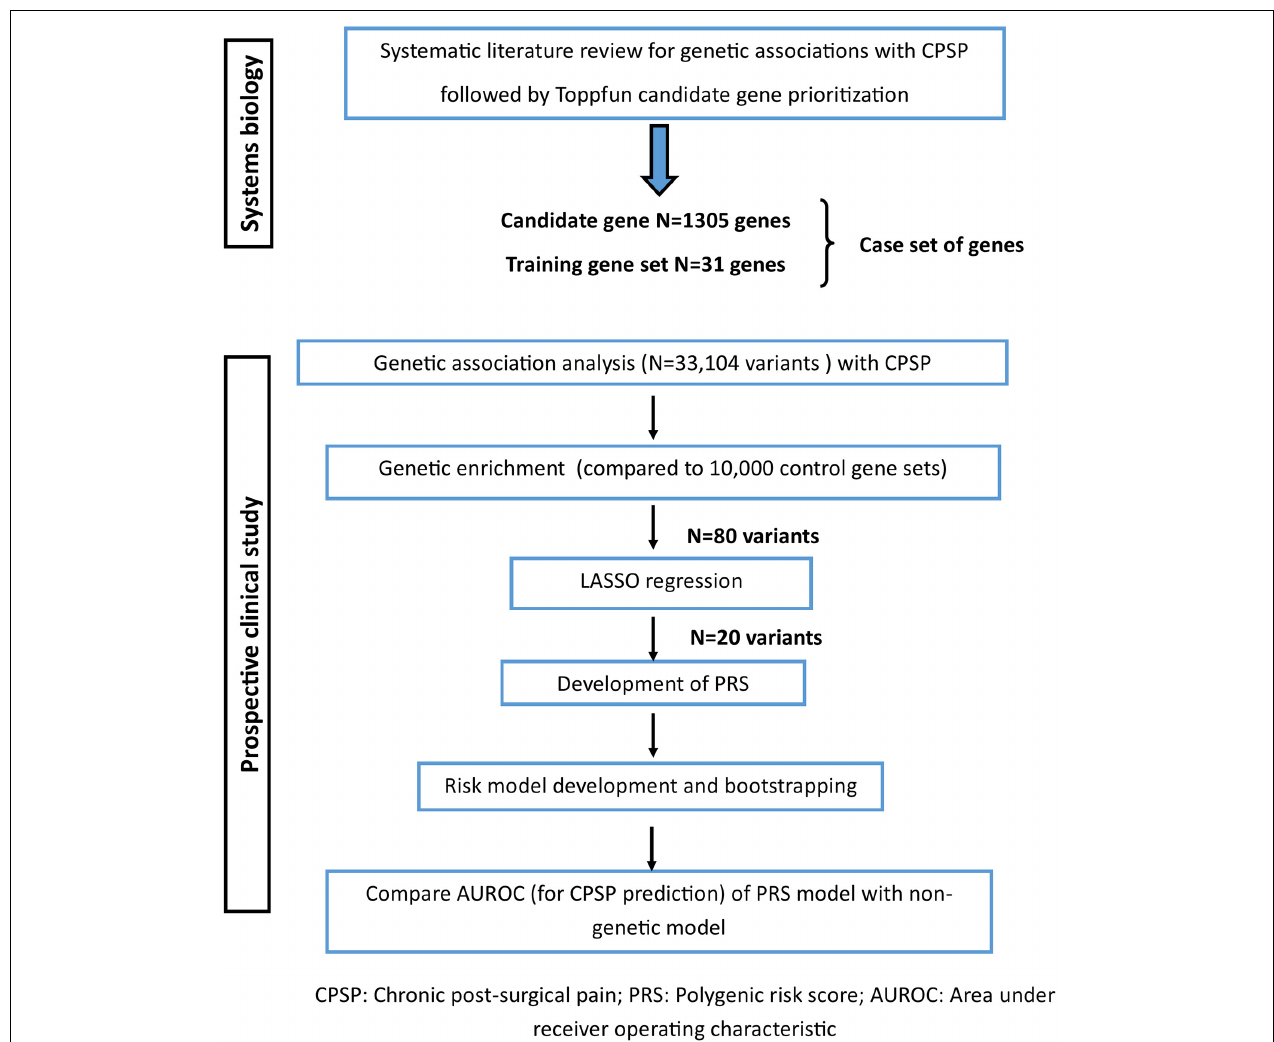
FIGURE 1 | Study flow showing steps involved with gene prioritization using systems biology followed by genetic association analyses in the clinical cohort to derive polygenic risk score based prediction model for chronic post-surgical